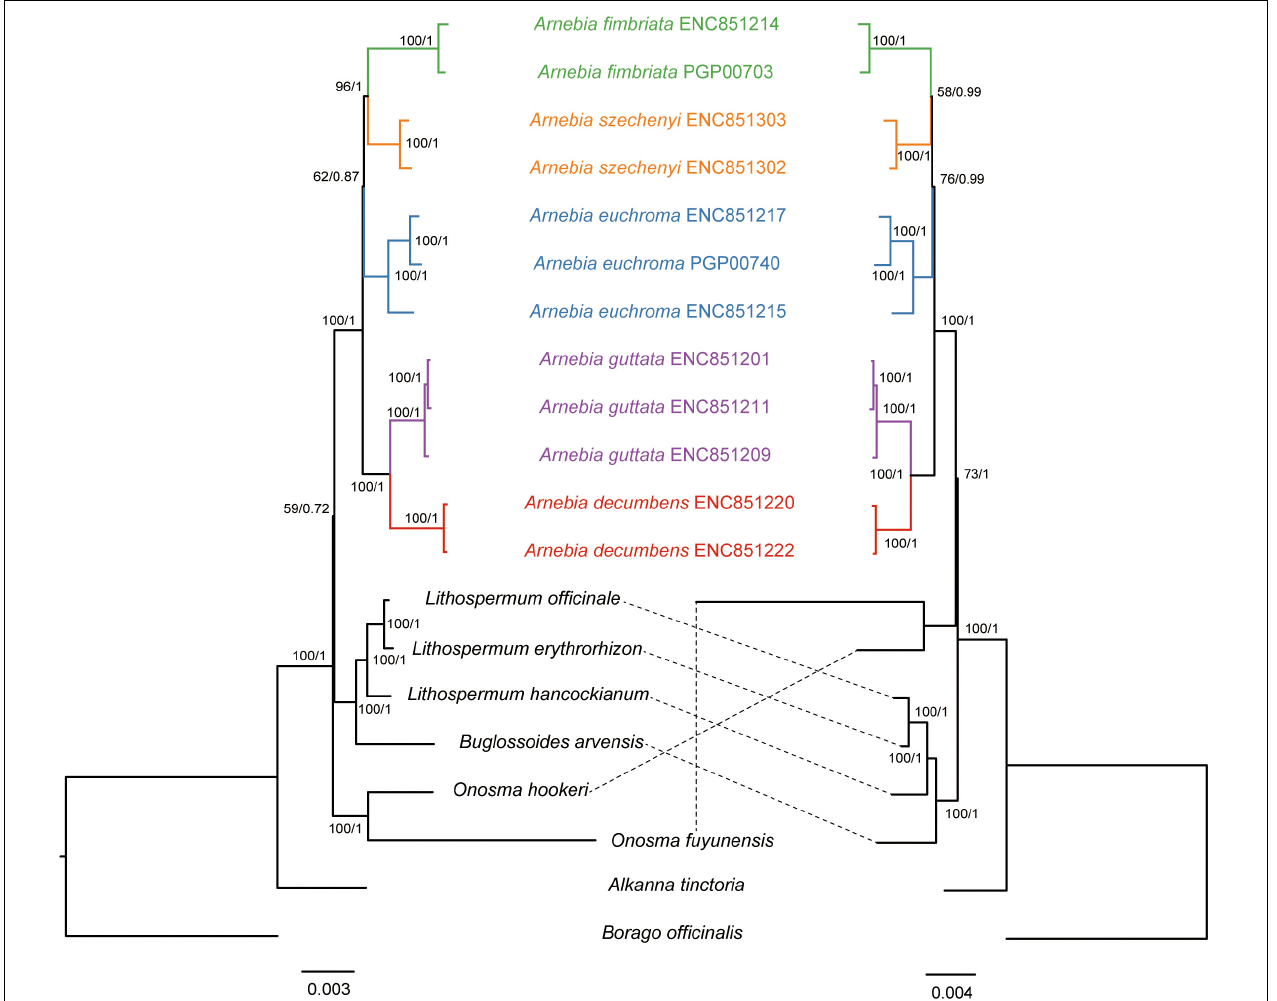
FIGURE 3 | Phylogenetic trees of Lithospermeae based on all protein-coding genes. The nucleotide dataset (left) and amino acid dataset (right) . Maximum likelihood (ML) bootstrap support values/Bayesian posterior probabilities are shown at each